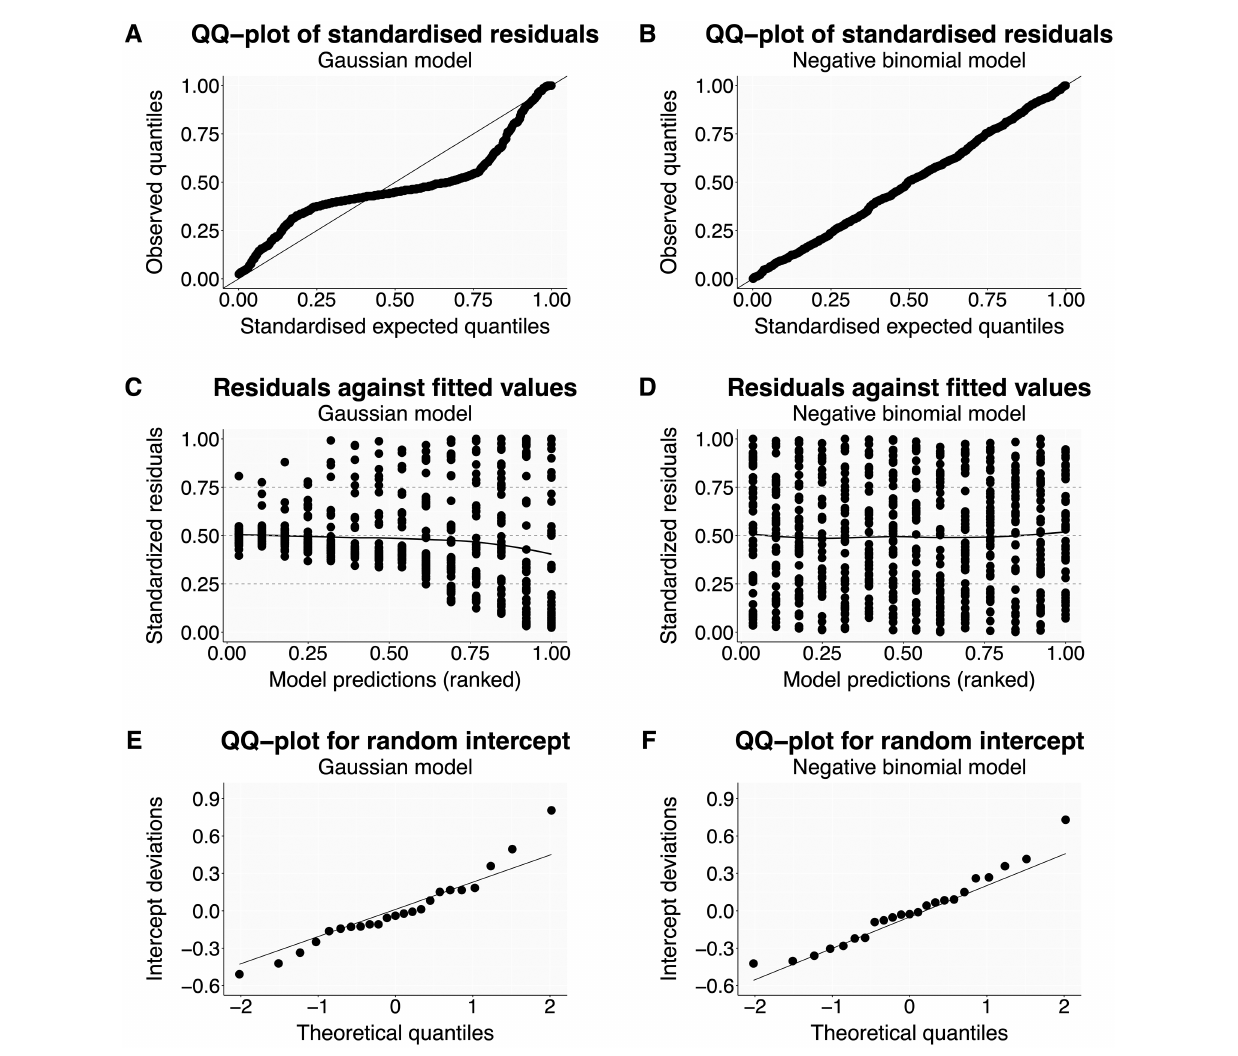
FIGURE 2 Distribution of residuals—examples. The left column shows residual plots for a Gaussian model with clear violations of model assumptions (A,C,E) . The right column shows the same residuals plots—now without issues after changing the distribution family to negative binomial (B,D,F) . The dataset from Price et al. (2016) is available with the R package glmmTMB (Brooks et al.,